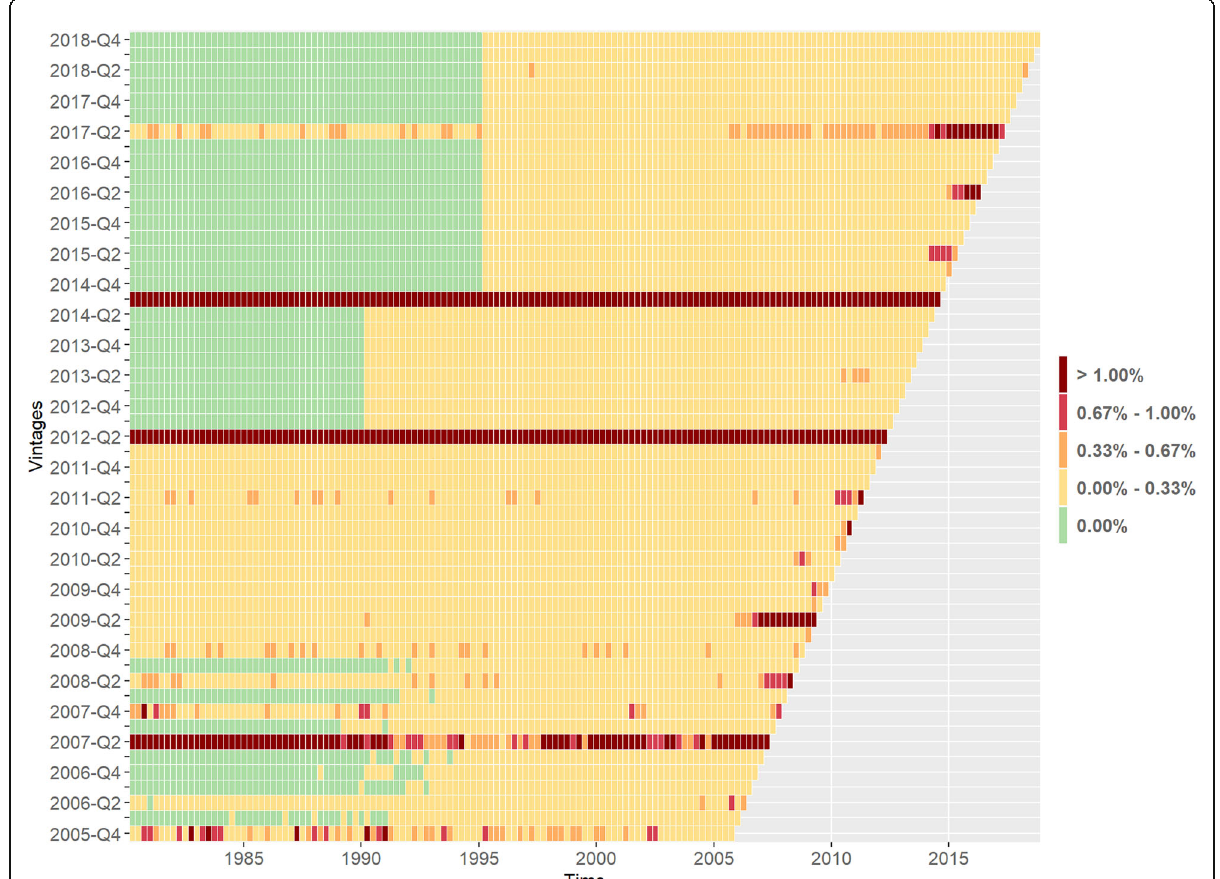
Fig. 3 GDP revisions in Switzerland since 2005. Quarter to quarter GDP absolute difference, in %. Sources: SECO, SFSO, SNB. Note: For each GDP vintage since 2005Q4, we present the relative difference, in absolute terms, relative to the previous quarter release. Dark red rectangles represent revisions of greater than 1% (11 GDP vintages concerned). Red rectangles represent revisions of between 0.66% and 1% (4 additional GDP vintages